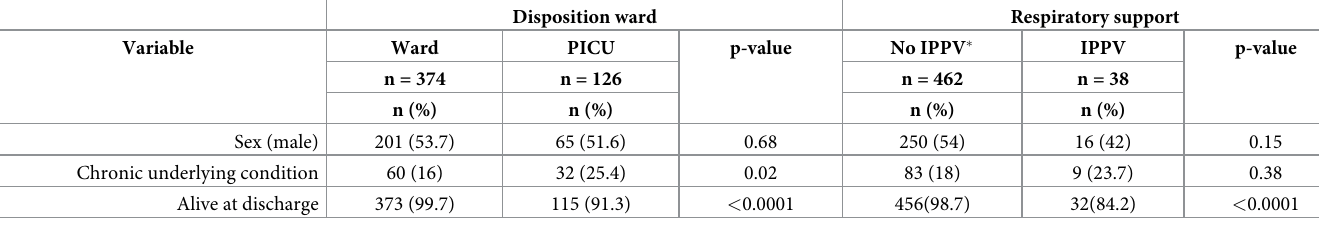
Table 4. Comparison of children by disposition ward and type of respiratory